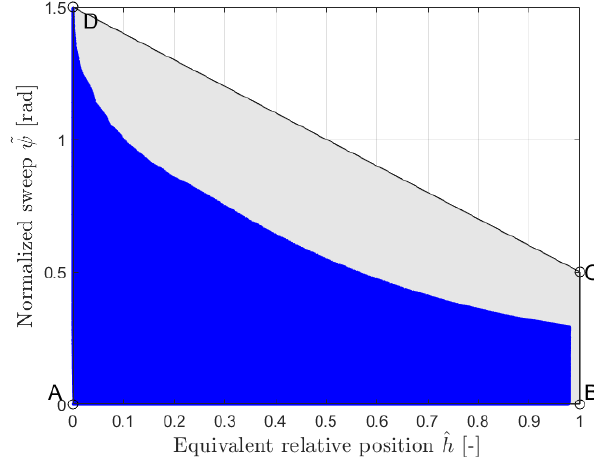
tip (Li et al., 2018).